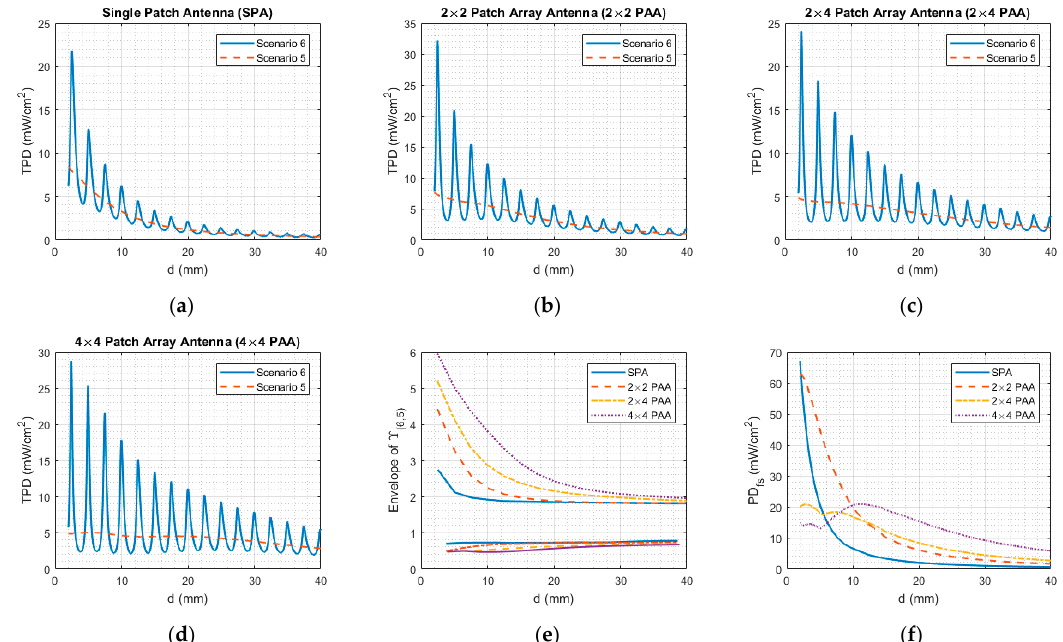
Figure 6. Equivalent sources without (scenario 5) and with (scenario 6) PEC: ( a ) peak TPD from SPA; ( b ) peak TPD from 2 × 2 PAA; ( c ) peak TPD from 2 × 4 PAA; ( d ) peak TPD from 4 × 4 PAA; ( e ) envelopes (min. and max.) of Υ ( 6,5 ) ; ( f ) free-space peak power density.